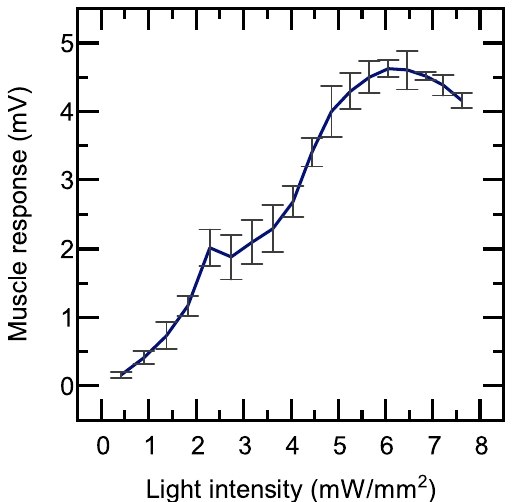
Figure 5. Electrical response from mouse hindlimb muscles during increased intensity of blue light stimulation on the sciatic nerve.